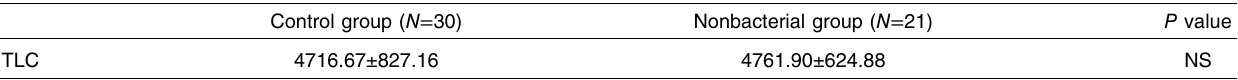
Table 10 Comparison between mean values of TLC in the control and nonbacterial